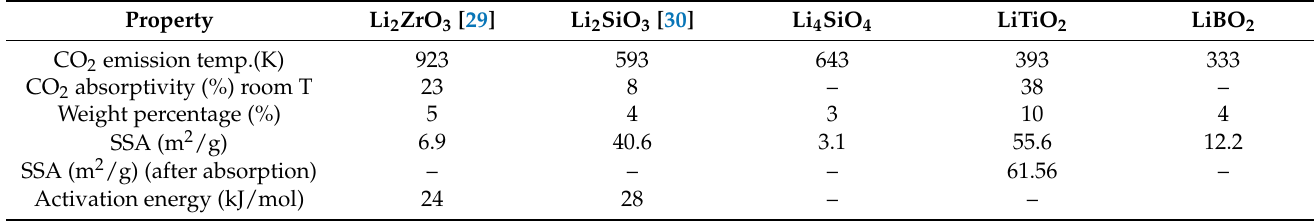
Table 10. CO 2 capture properties of lithium-based oxides synthesized by sol–gel method.